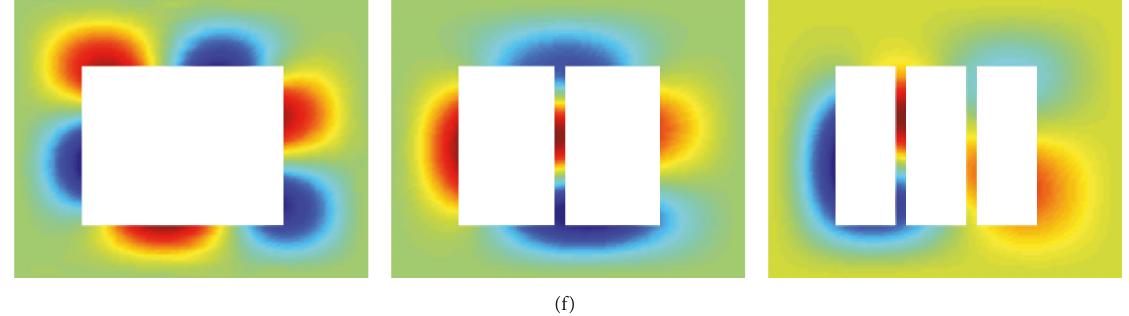
Figure 10: The first six mode shapes for different cutout numbers: the plate with one cutout (the left plot), the plate with two cutouts (the middle plot), and the plate with three cutouts (the right